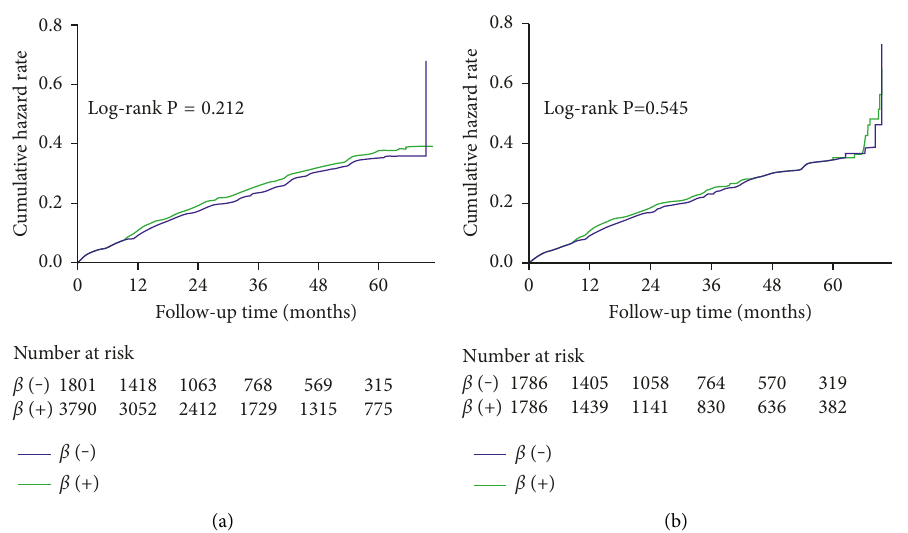
Figure 3: Kaplan–Meier curve for MACCE before (a) and after (b) propensity score matching patients in the β -blocker and no β -blocker groups. MACCE, major adverse cardiac and cerebral